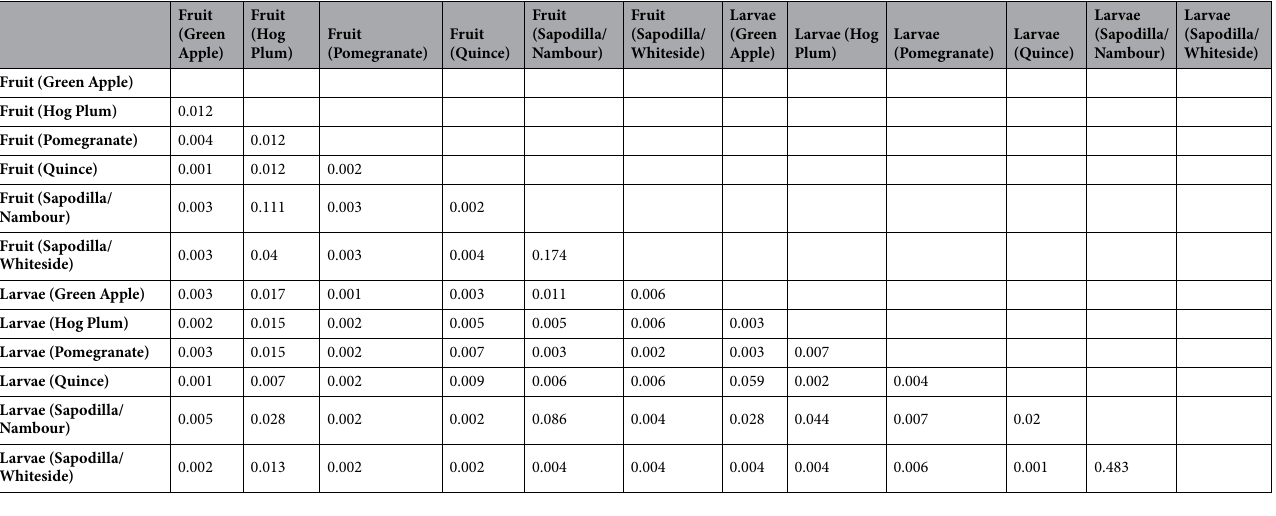
Table 2. PERMANOVA test (P values) from Pair-wise tests to compare the variation of the bacterial community between five different fru it and their larvae ( B. tryoni